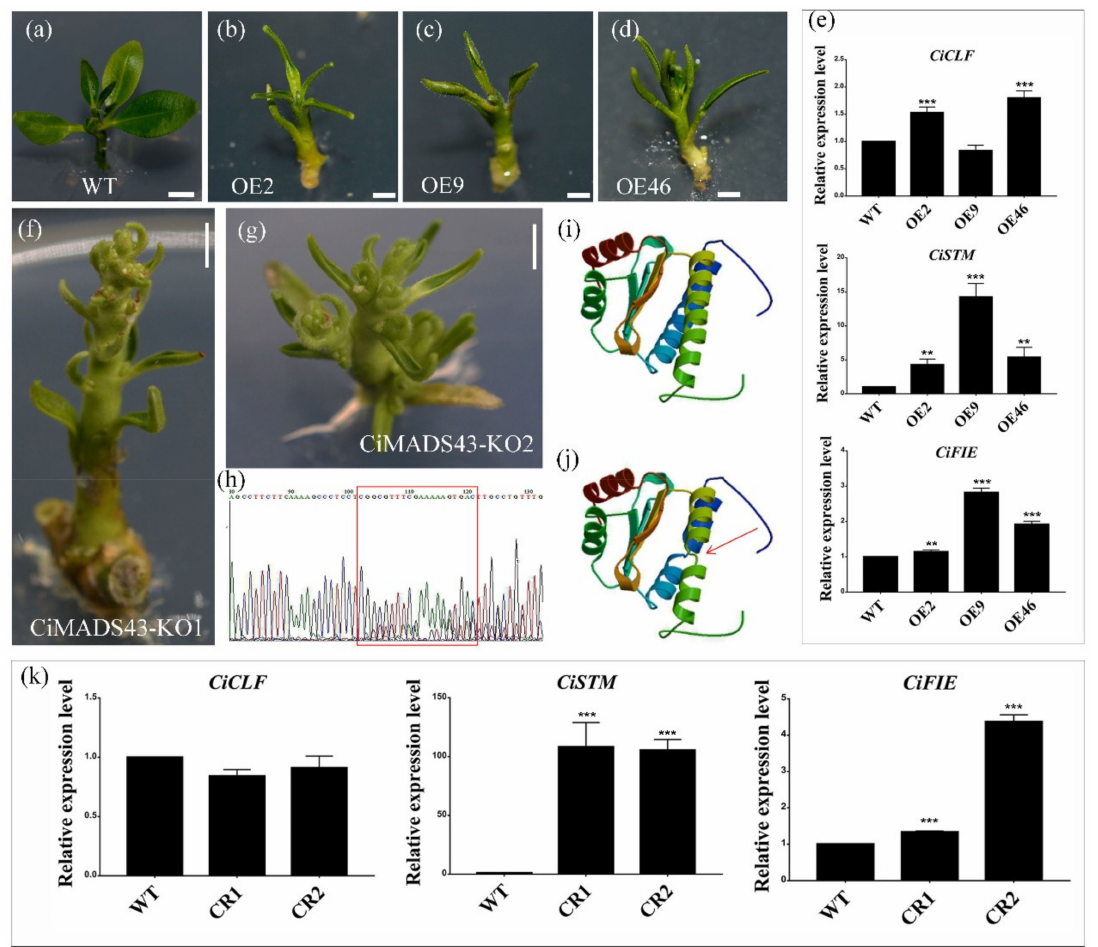
Figure 3. Overexpression and knockout of CiMADS43 in lemon. ( a ) Wild type lemon. ( b – d ) The phenotype of three overexpressed citrus transgenic lines with CiMADS43 . ( e ) qRT-PCR analysis of citrus leaf development related genes ( CLF , STM , and FIE ) in CiMADS43 overexpression lines. ( f , g ) Phenotypic analysis of CiMADS43 knockout lines by CRISPR/Cas9 system. ( h ) DNA sequencing analysis of gRNA target in CiMADS43 knockout lines. The red box indicates the position of the gRNA target. Double peaks appears due to the deletion of three nucleotides adjacent to the PAM (Protospacer Adjacent Motif) region. ( i , j ) The three-dimensional structure of CiMADS43 protein ( i ) and the residual protein which knocked out three bases by CRISPR/Cas9 system ( g ). The red arrow indicates the location of the change. ( k ) qRT-PCR analysis of citrus leaf development related genes ( CLF , STM , and FIE ) in CiMADS43 knockout lines. Scale bar = 0.2 cm. Statistically significant is marked with asterisk(s) (** p < 0.01 and *** p < 0.001, Student’s t